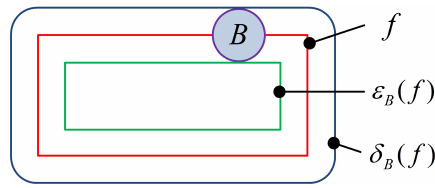
Figure 6. Schematic diagram of corrosion and expansion operation.